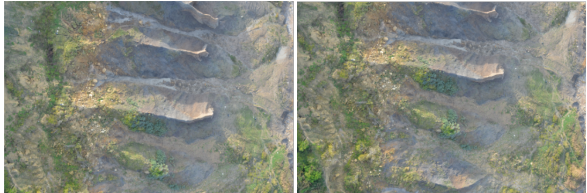
Figure 3. Example of visible images obtained during the acquisition.